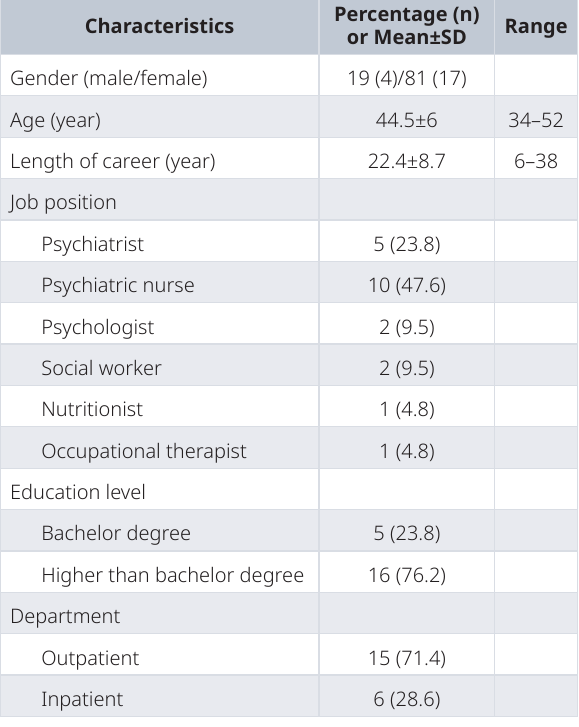
Table 1. Demographic data of the health professionals.